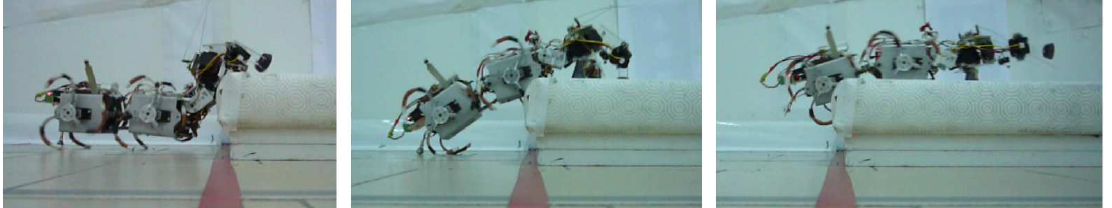
Figure 12. Series of snapshots of the robot while overcoming an obstacle of 11 cm with the help of the front